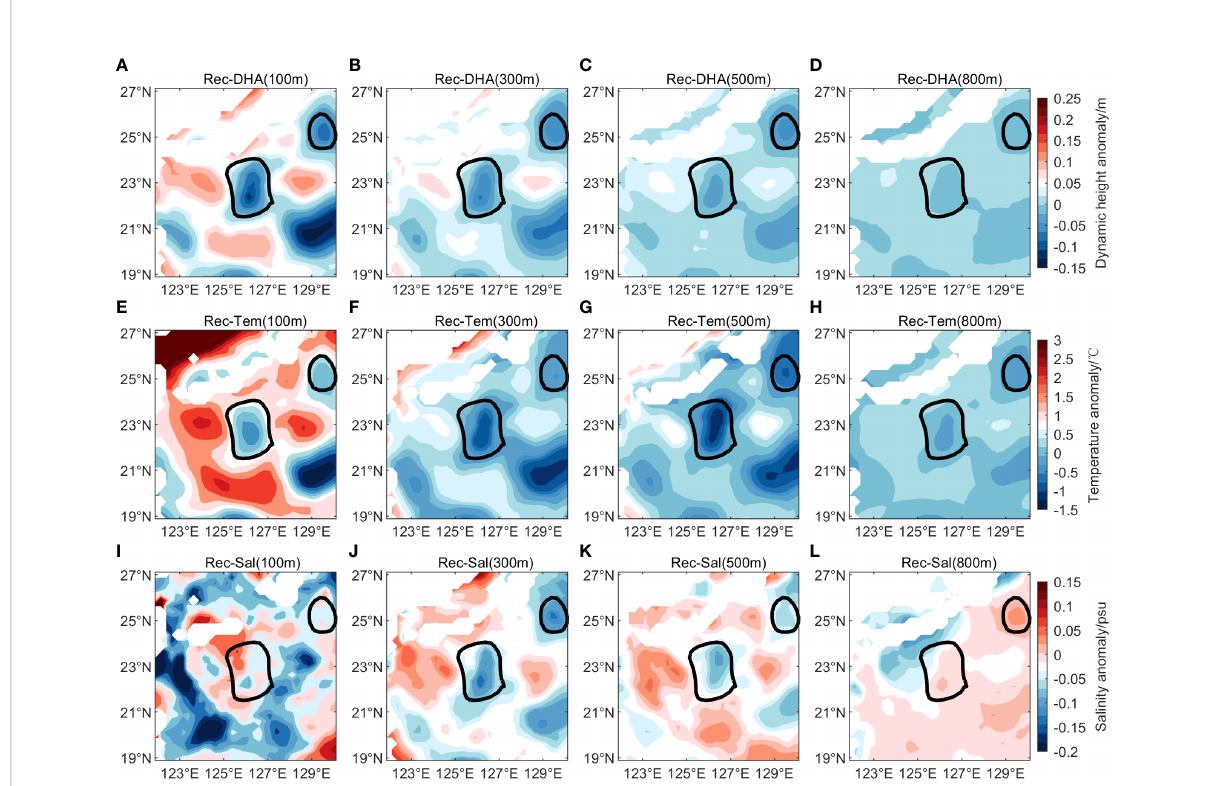
FIGURE 6 The distribution of the anomaly fi elds of dynamic height, temperature and salinity from the synthetic fi elds and on May 13, 2019. From left to right: 100m, 300m, 500m, and 800m. (A – D) the dynamic height anomaly fi elds of the synthetic fi elds, (E – H) the temperature anomaly fi elds of the synthetic fi elds, (I – L) the salinity anomaly fi elds of the synthetic fi elds. The circles in the fi gure are mesoscale eddies identi fi ed by satellite SLA.